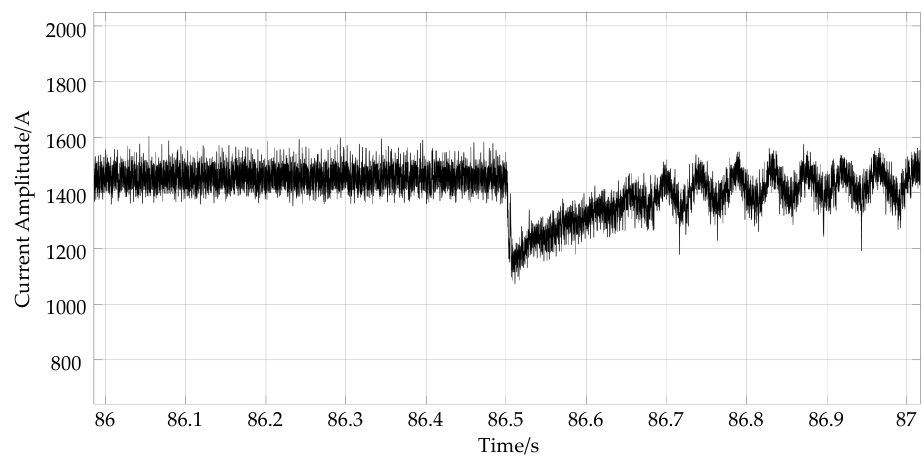
Figure 17. The q -axis current during stator switching. The current output from the converters at both ends is shown in Figures 18 and 19. Since the voltage drop on the cable needs to be compensated, from the prospective of the whole process, the output current of the converter at the start point decreases as the train runs, while the output current of the converter at the end point increases.